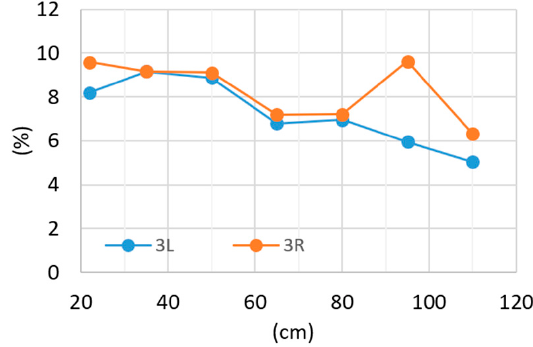
Figure 8. Point moisture according to Table